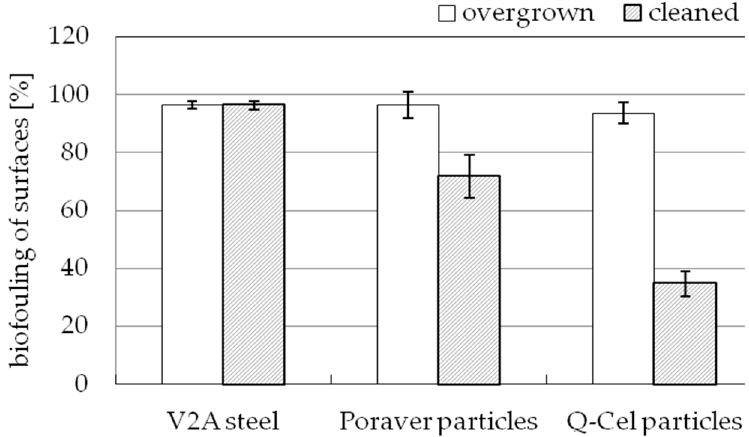
Figure 5. Mean values and standard deviations of the percentage biofouling ( n = 3) of the test surfaces removed compared to the reference V2A-steel before and after water jet cleaning.